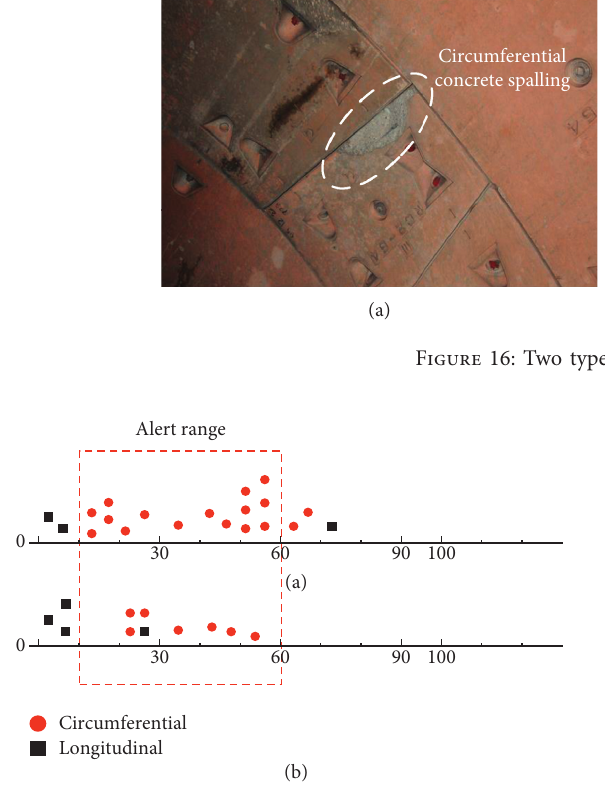
Figure 17: Distribution of spalling blocks: (a) westbound tunnel and (b) eastbound